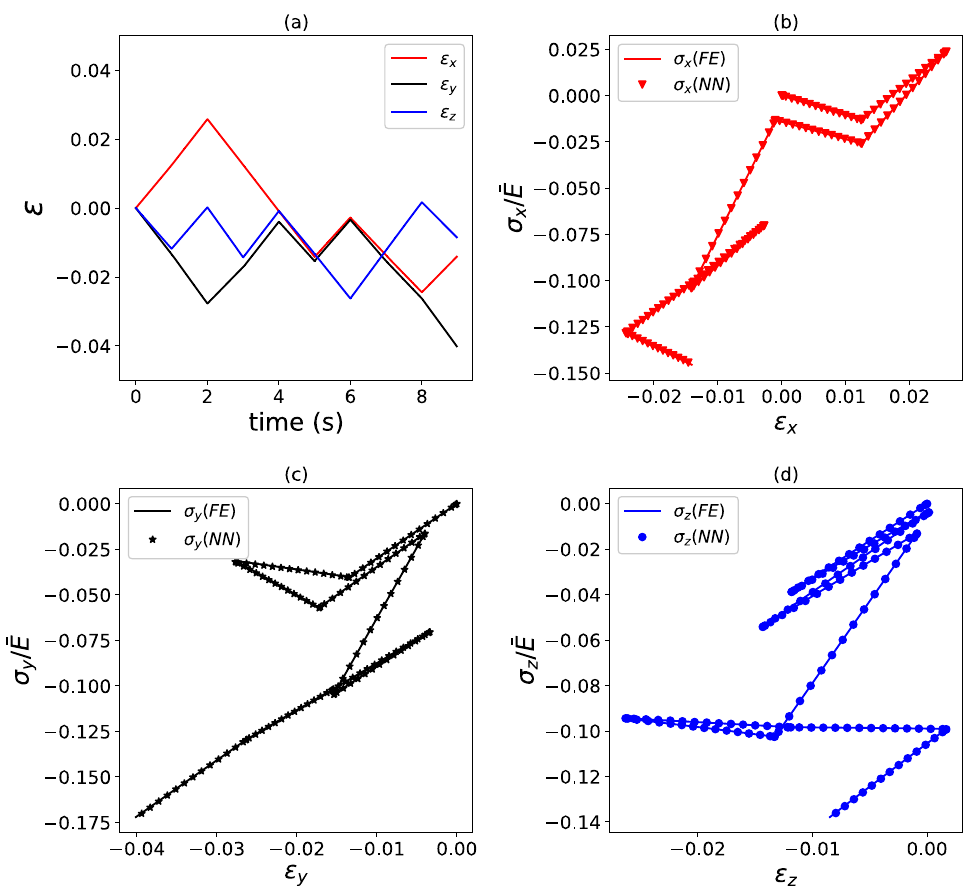
Figure 4. Example of strain versus time ( a ) and stress versus strain ( b – d ) histories for a hyperelastic composite with κ = 2.0. FE predictions are compared to predictions by a surrogate model. E σ = 1.7% for the load case shown, which used φ = 4000 training data points.